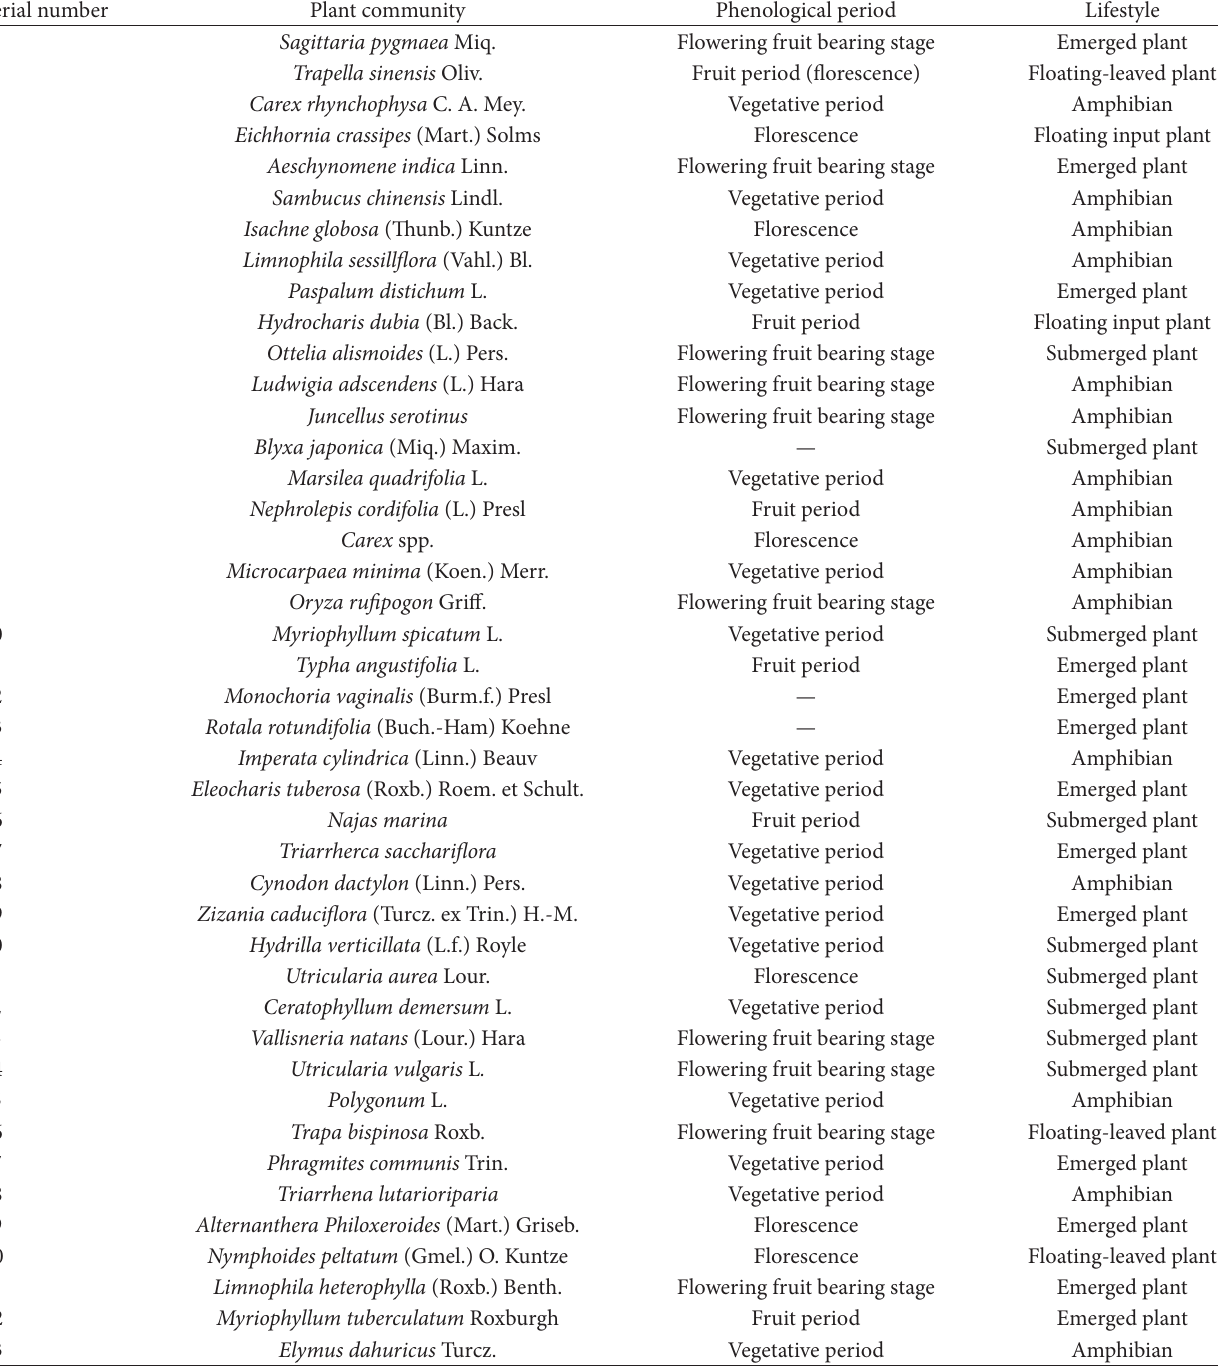
Table 1: The composition of macrophytes in the Poyang Lake (September 7–14,